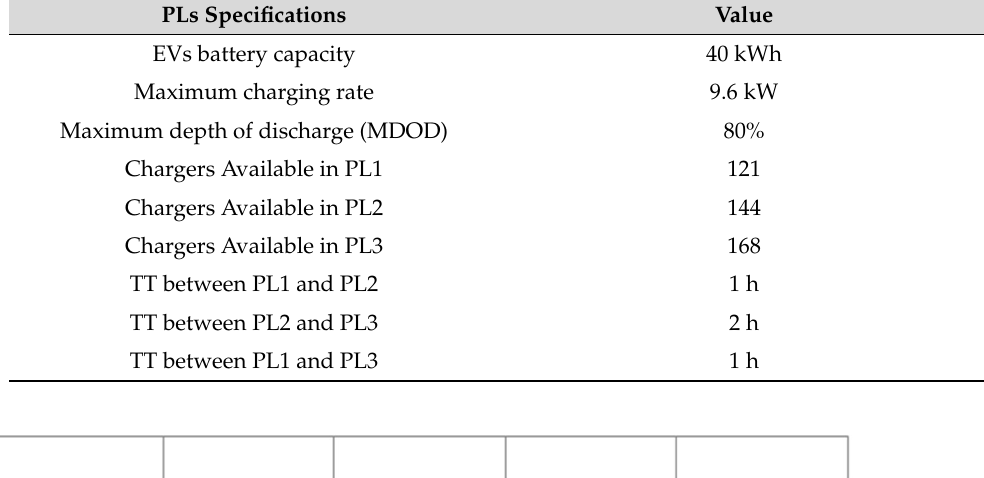
Table 1. Model parameters.